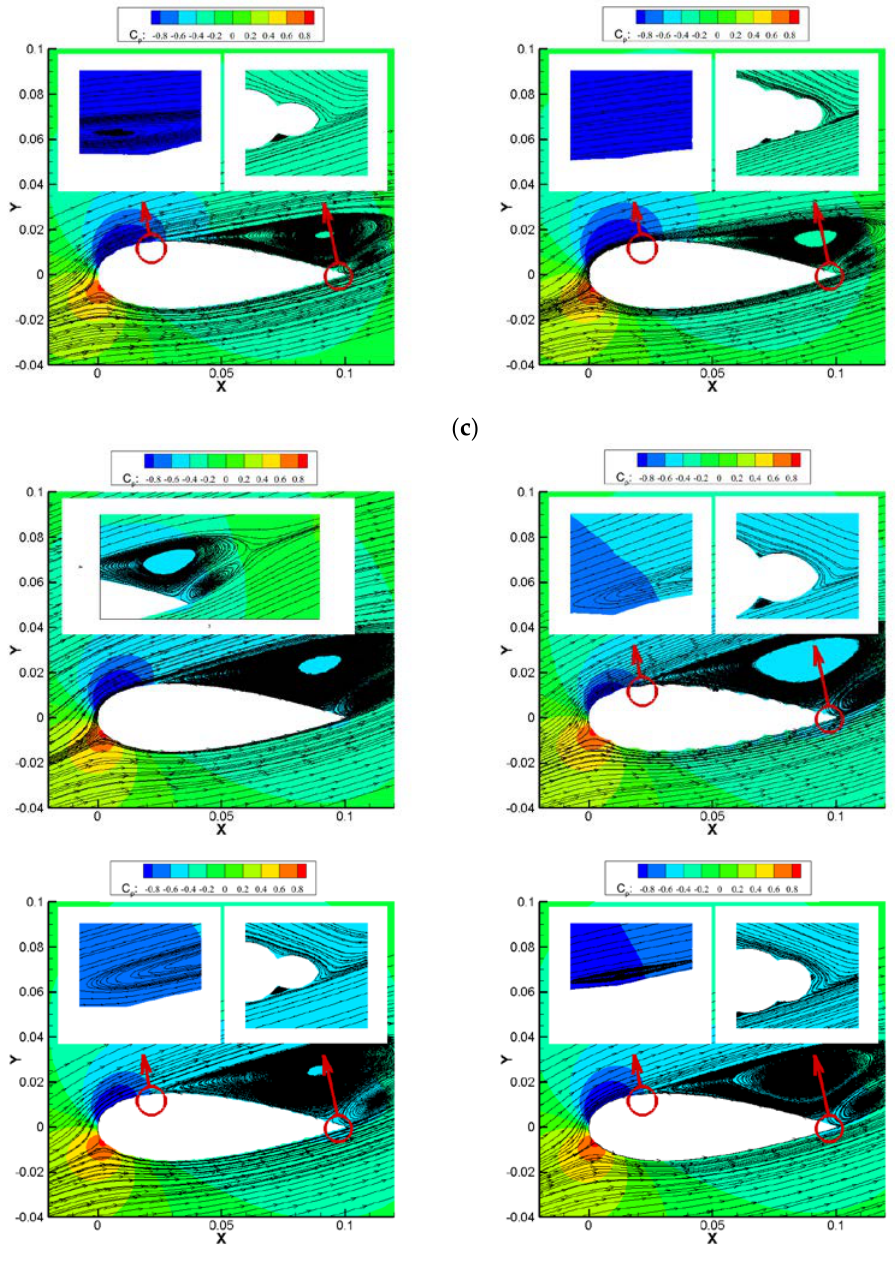
Figure 8. Comparisons of pressure field and streamlines for NACA0030 and the three corrugated airfoils at different angles of attack: ( a ) 0°, ( b ) 8°, ( c ) 16°, and ( d ) 20°.